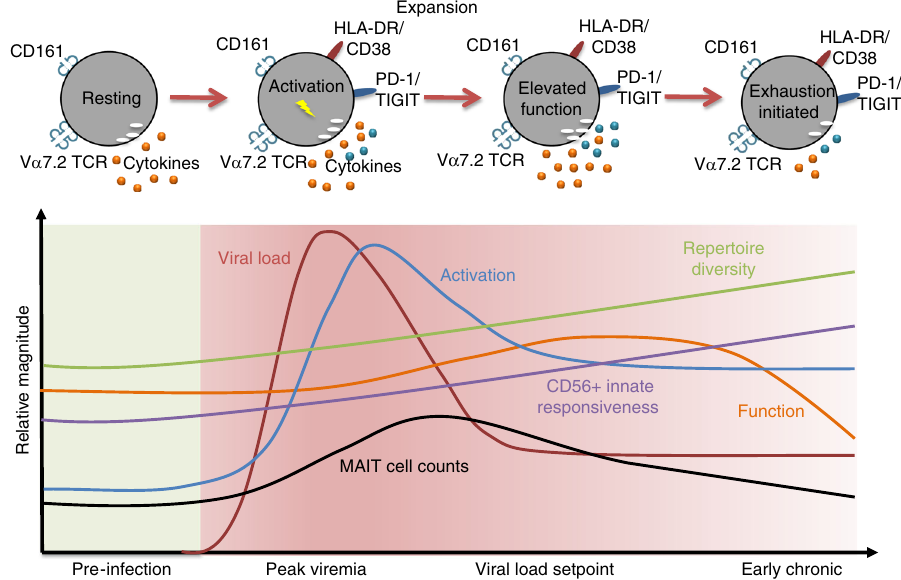
Fig. 8 Dynamic response of the MAIT cells compartment during acute HIV-1 infection. Schematic view of the complex response pattern of MAIT cells from pre-infection, to peak viremia, over the viral load set-point, into early chronic